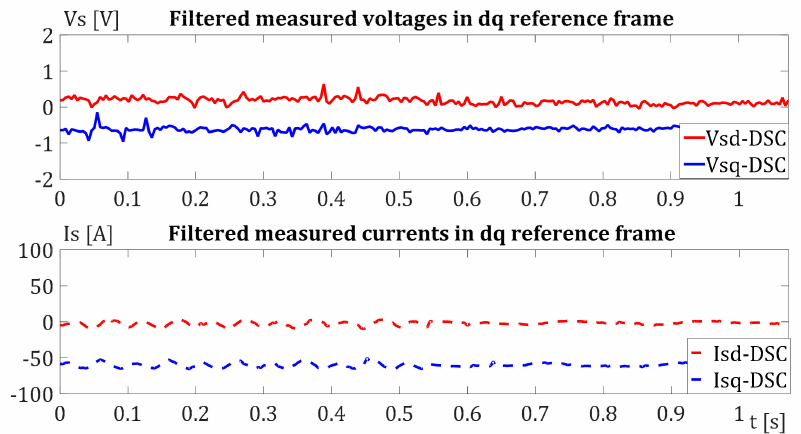
Figure 13. Experimental results for filtered voltage and current in the dq reference frame during current test